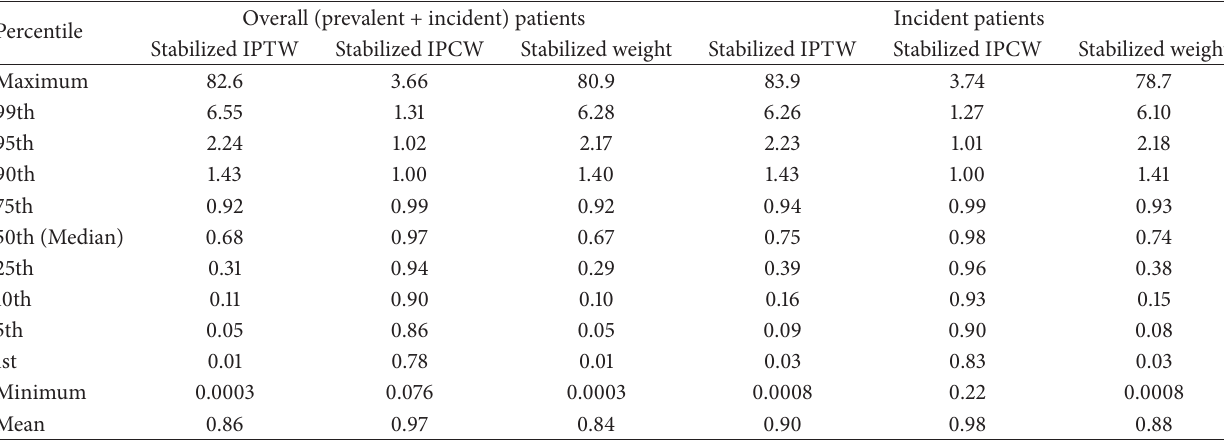
Table 2: Weight distribution for marginal structural model across 3-month time intervals.